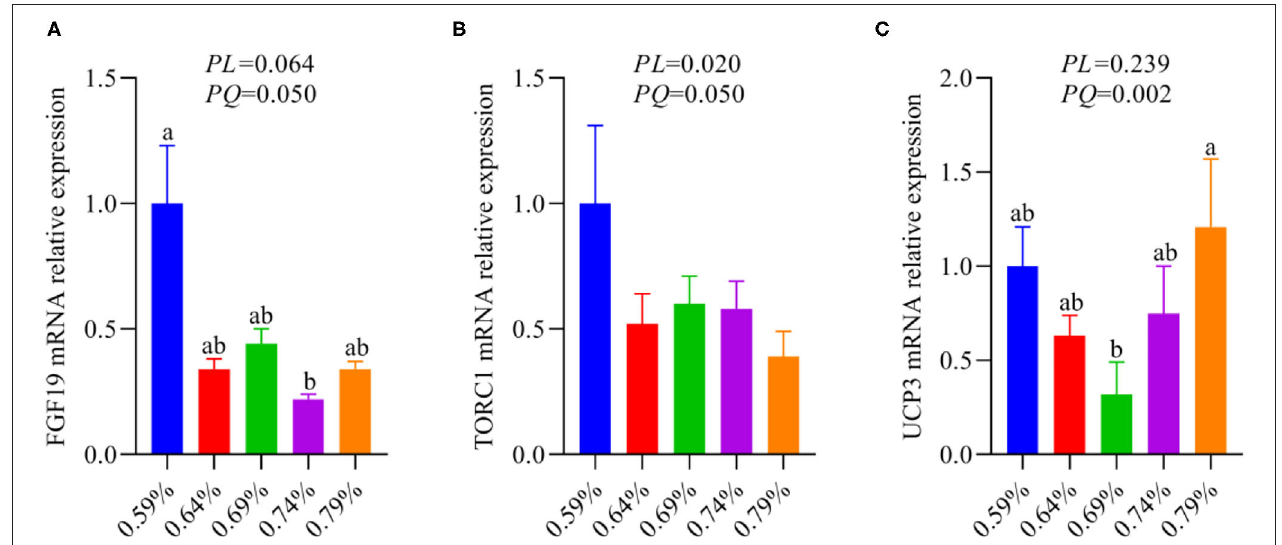
FIGURE 5 | The relative mRNA expression levels of an FGF19-TORC1 signaling pathway ( n = 6–8). (A) FGF19. (B) TORC1. (C) UCP3. a,b Means with different superscripts within a column differ significantly ( P < 0.05).